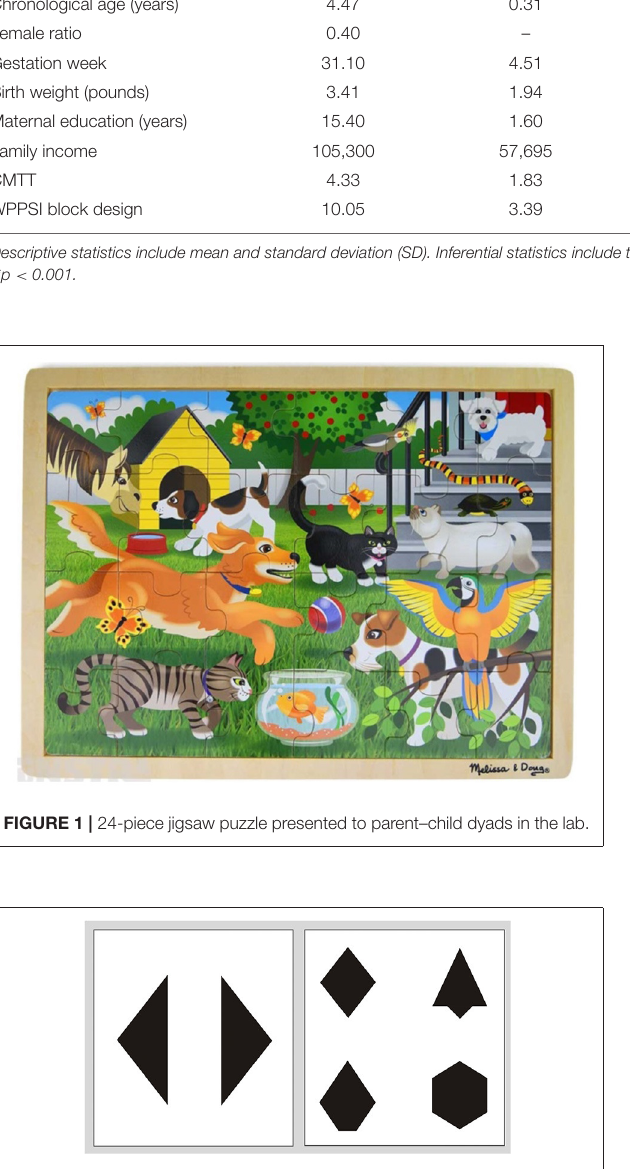
FIGURE 2 | Sample stimuli from the Children’s Mental Transformation Task (Levine et al., 1999). Children are asked to pick the shape that the two pieces would make when put